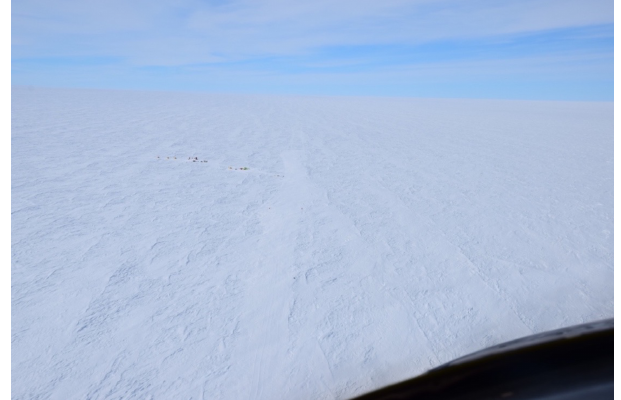
Figure A2. Sastrugi (as high as 0.5m) running in the west–east di- rection of approximately 80 ◦ at Mount Brown South in East Antarc- tica during austral summer 2017/2018 can be seen, particularly to the right of the image (a groomed ski-way for aircraft at a slightly deeper angle of approximately 110 ◦ can be seen in the centre of the image). This indicates that the prevailing winds during the summer 2017/2018 season were east–north-easterlies. Photo credit: Doug Westersund/Kenn Borek Air.